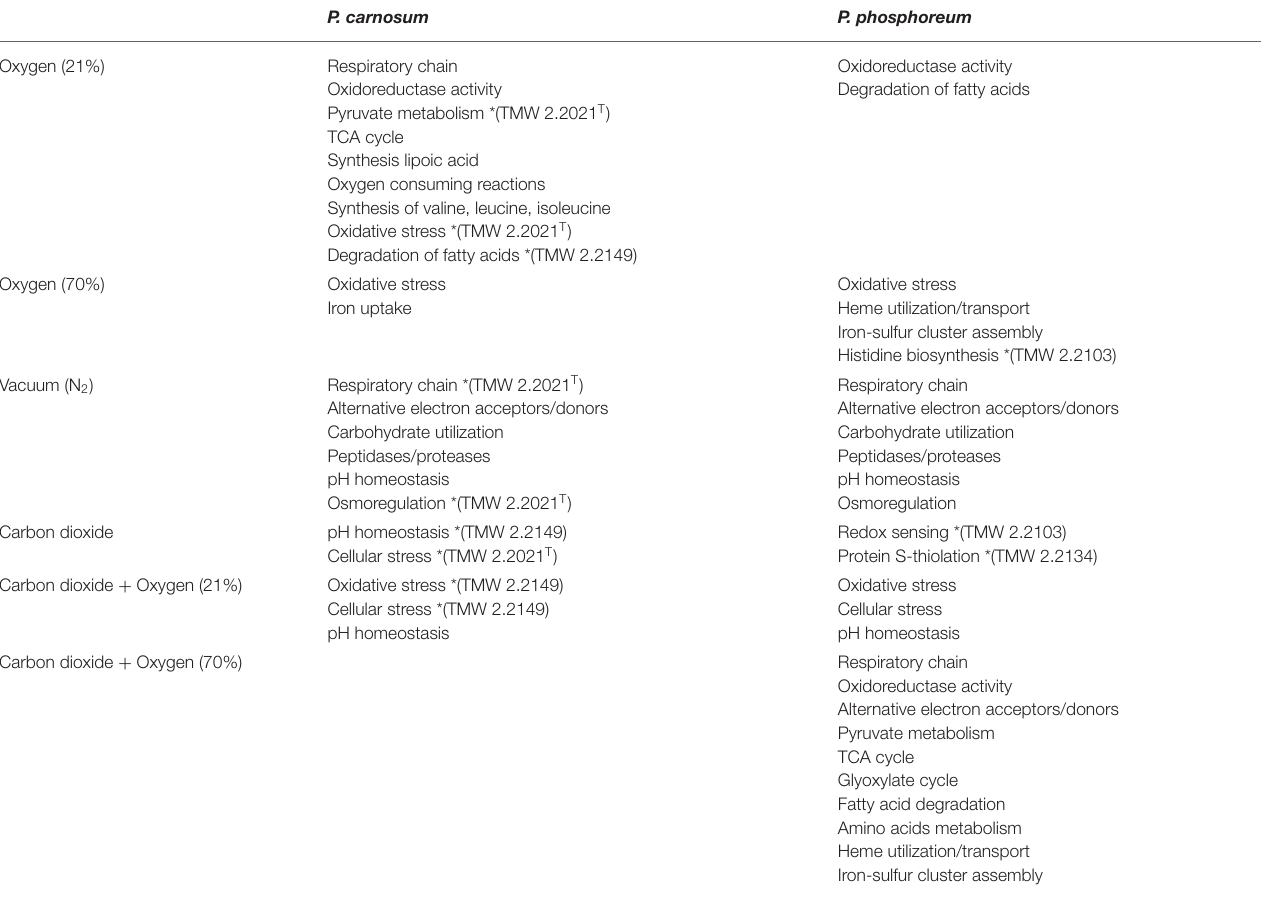
TABLE 2 | Summary of observed pathways/reactions were affected as a consequence of the different gases and concentrations for both species of